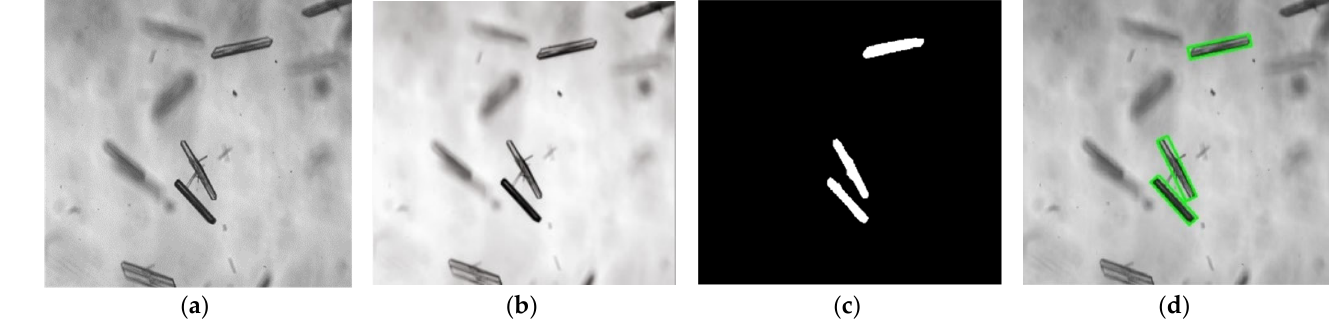
Figure 6. Segmentation and measurement results of the LGA image: ( a ) captured image; ( b ) image preprocessing; ( c ) segmented image with an improved U ‐ net; ( d ) rectangle fitting.